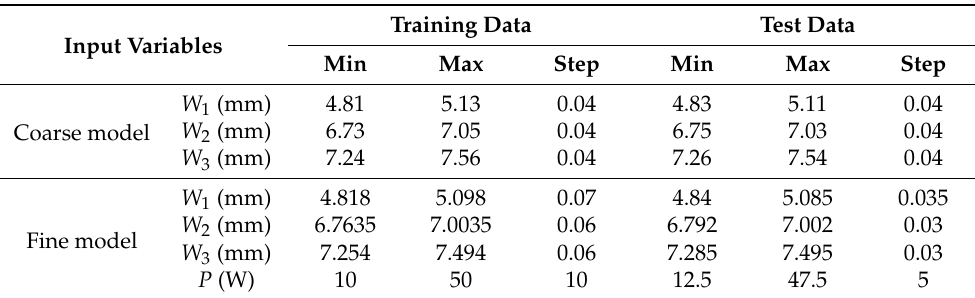
Table 1. Definition of training and test data for multiphysics parametric modeling of the iris coupled microwave cavity filter.